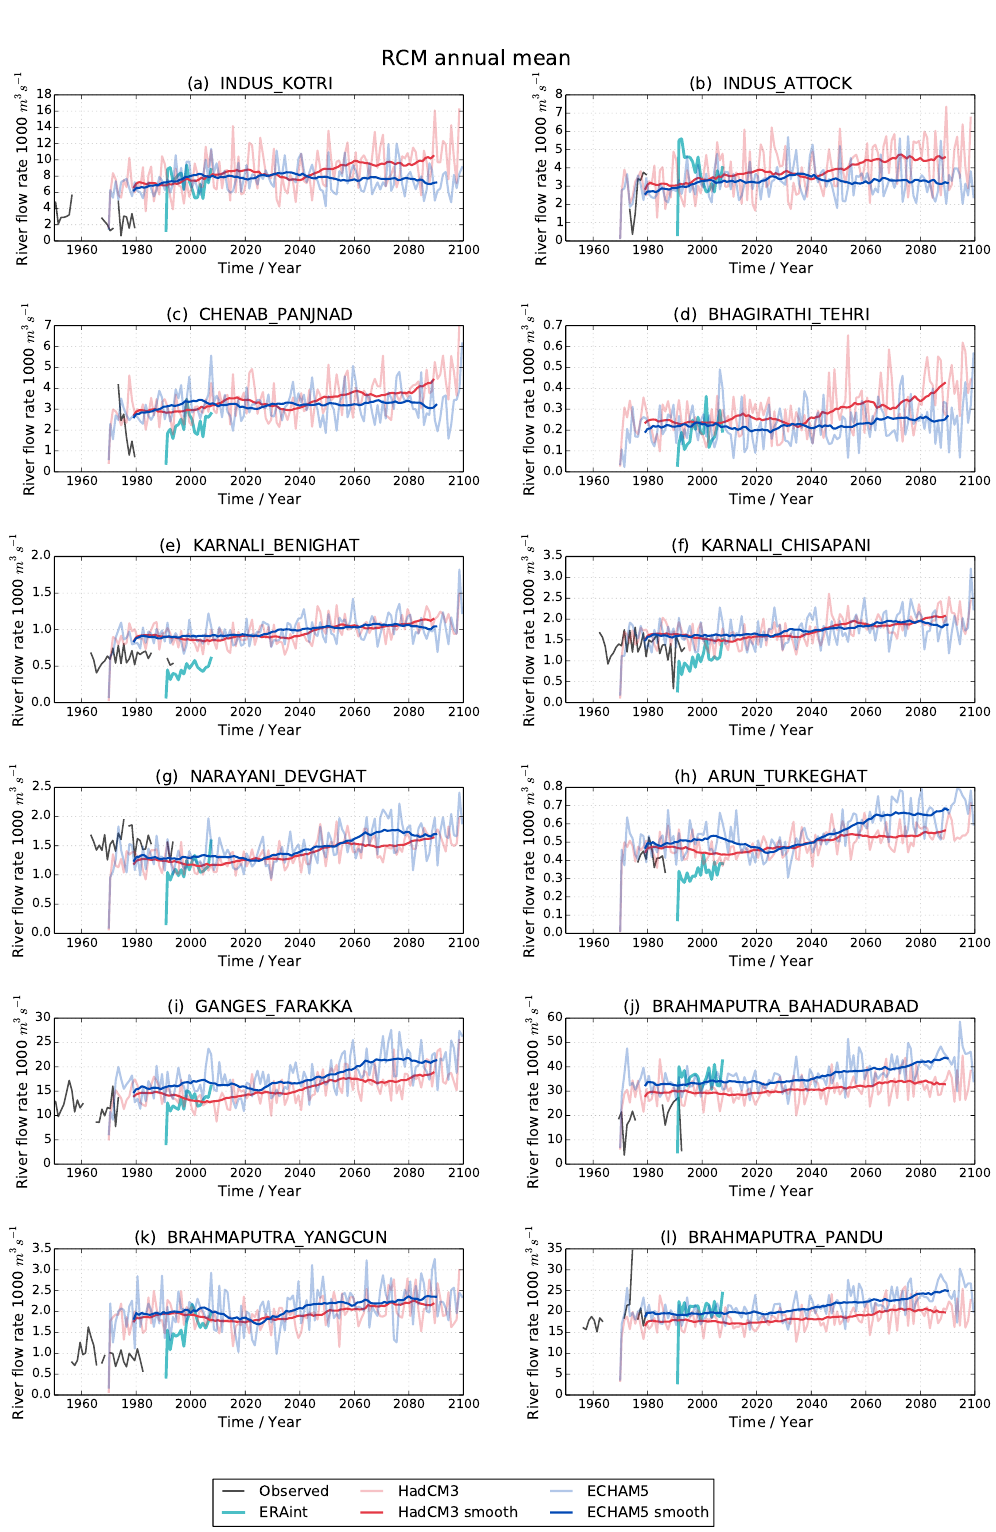
Figure 8. Time series of river flows showing available observations (black) and RCM runs (HadCM3 – red, ECHAM5 – blue, ERAint – cyan lines) from 1971 to 2100. Paler lines are annual averages and darker lines are a 20-year rolling smoothed